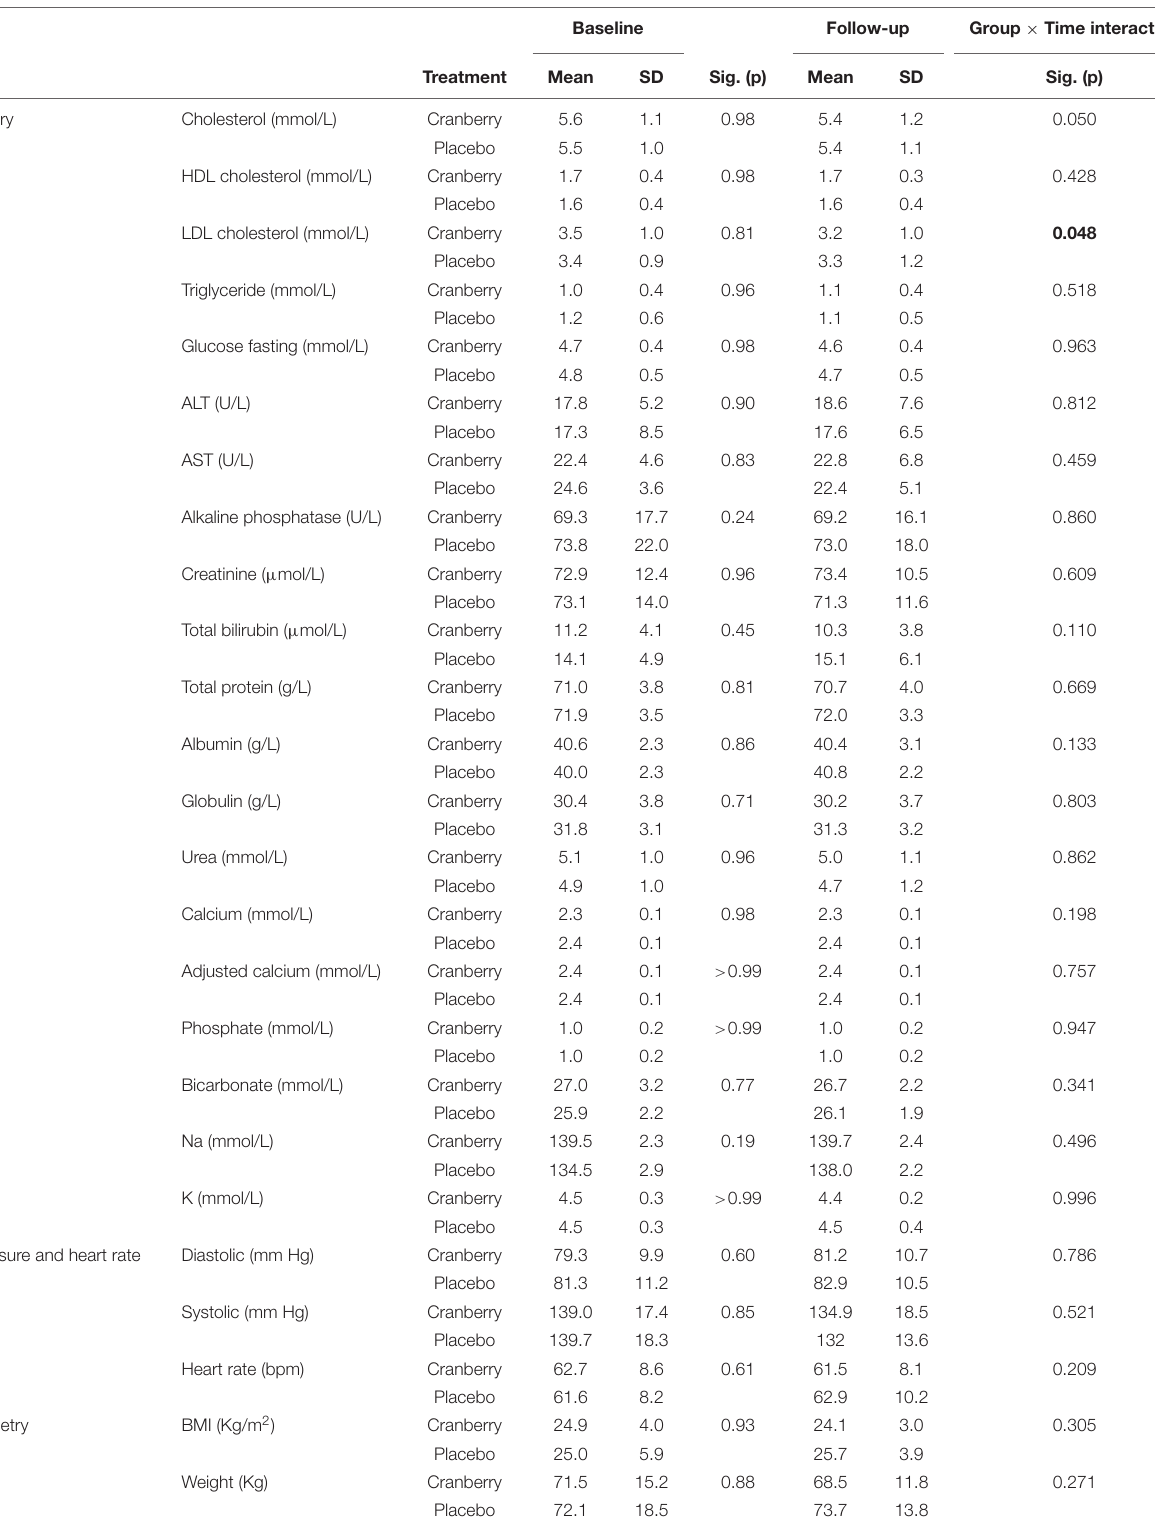
TABLE 4 | Blood biochemistry, blood pressure, heart rate and anthropometry at baseline and follow-up, differences between groups at baseline (Mann-Whitney U Independent-Samples Test), and group × time interactions on linear mixed modelling.